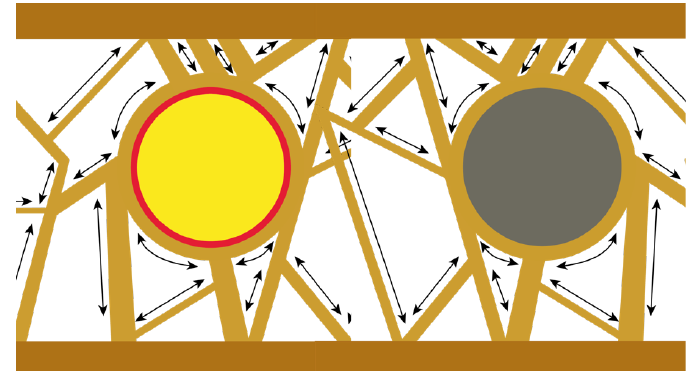
Figure 2. Schematic presentation of a cyst (yellow circle) and an integrated implant (grey circle) inside the bone. The cyst is a foreign body which is surrounded by a cortical bone because it disrupts the continuity of the bone structure. Likewise, the endosseous implant represents such a disruption. Both foreign bodies are extra-territorialized by a cortical bone.